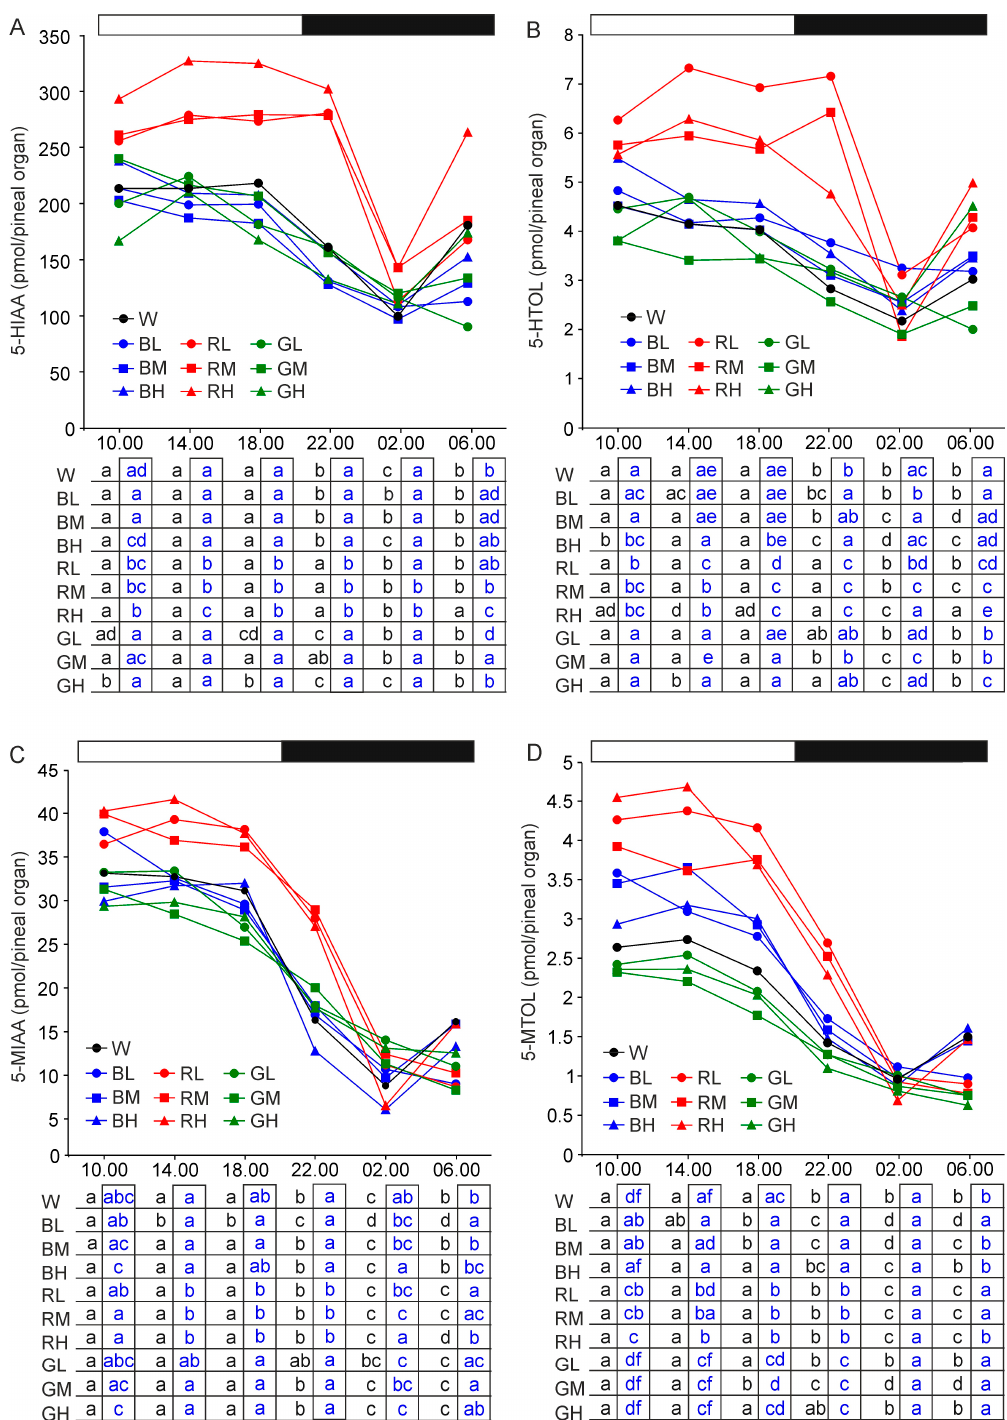
Figure 4. Content (means) of 5-hydroxyindoleacetic acid, 5-HIAA ( A ), 5-hydroxytryptophol, 5-HTOL ( B ), 5-methoxyindoleacetic acid, 5-MIAA ( C ), and 5-methoxytryptophol, 5-MTOL ( D ) in the pineal organs of turkeys kept under white light (W) with intensity of 16 lx, blue light with intensities of 16 lx (BL), 32 lx (BM), and 64 lx (BH), red light with intensities of 16 lx (RL), 32 lx (RM), and 64 lx (RH), green light with intensities of 16 lx (GL), 32 lx (GM), and 64 lx (GH) during the photophase. For further explanation, see Figure 1.